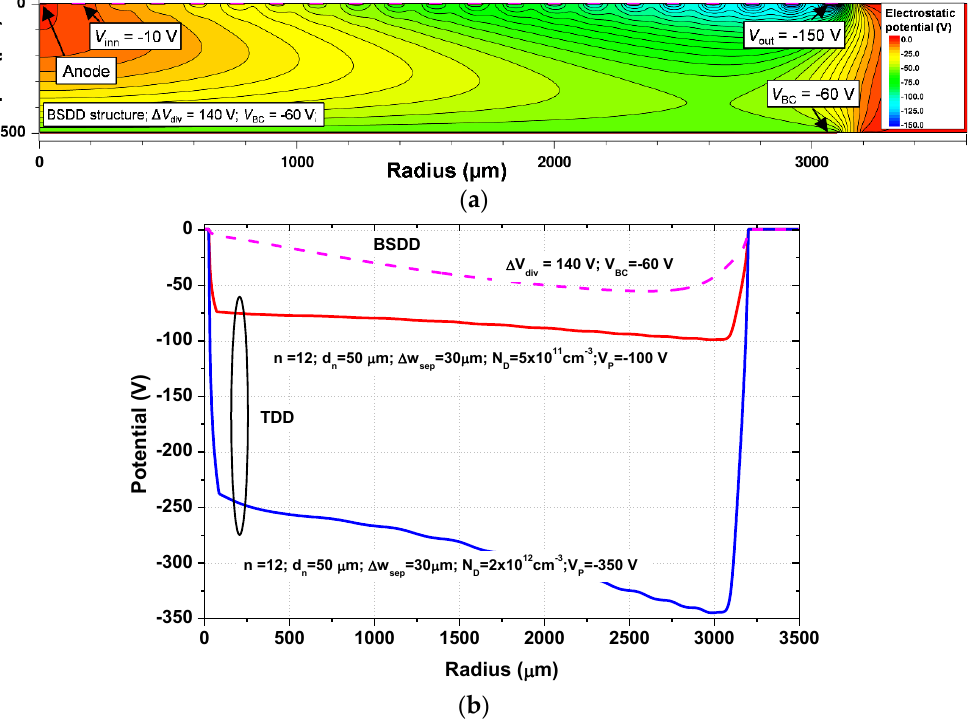
Figure 9. ( a ) Electrostatic potential distribution for a BSDD device; ( b ) The electric potential along the drift valley of two TDD structures and a comparable BSDD with a r PD = 3100 µm.